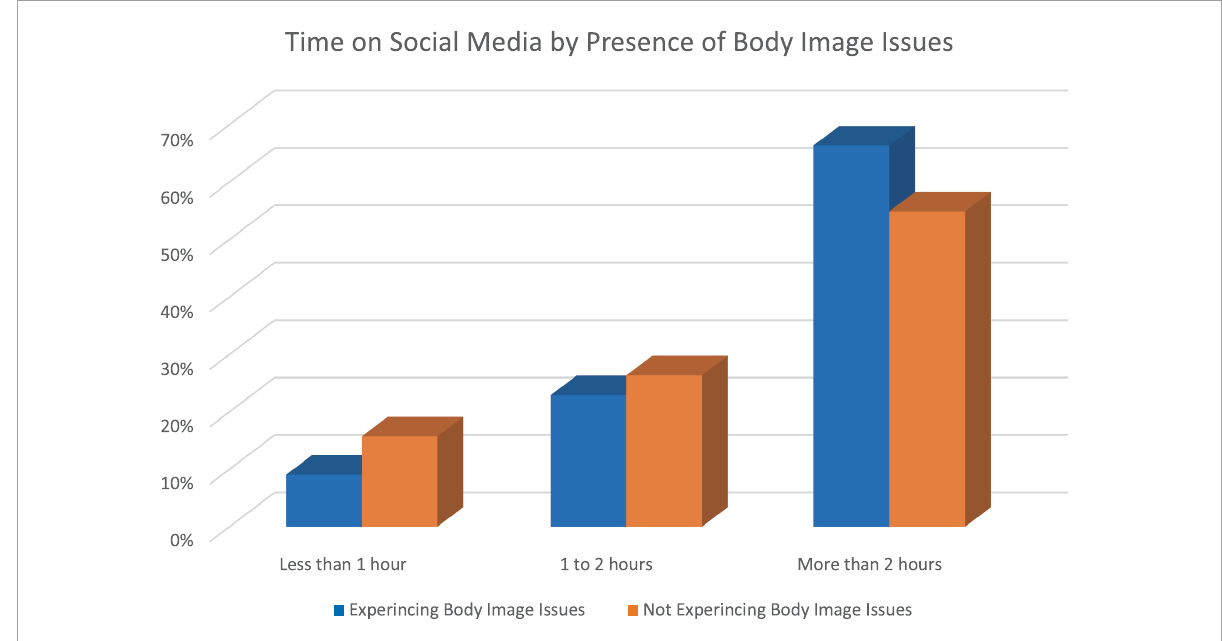
FIGURE2 Increase in daily time spent on social media (SM) platforms has a dose-response relationship to increasing self-reported body image issues